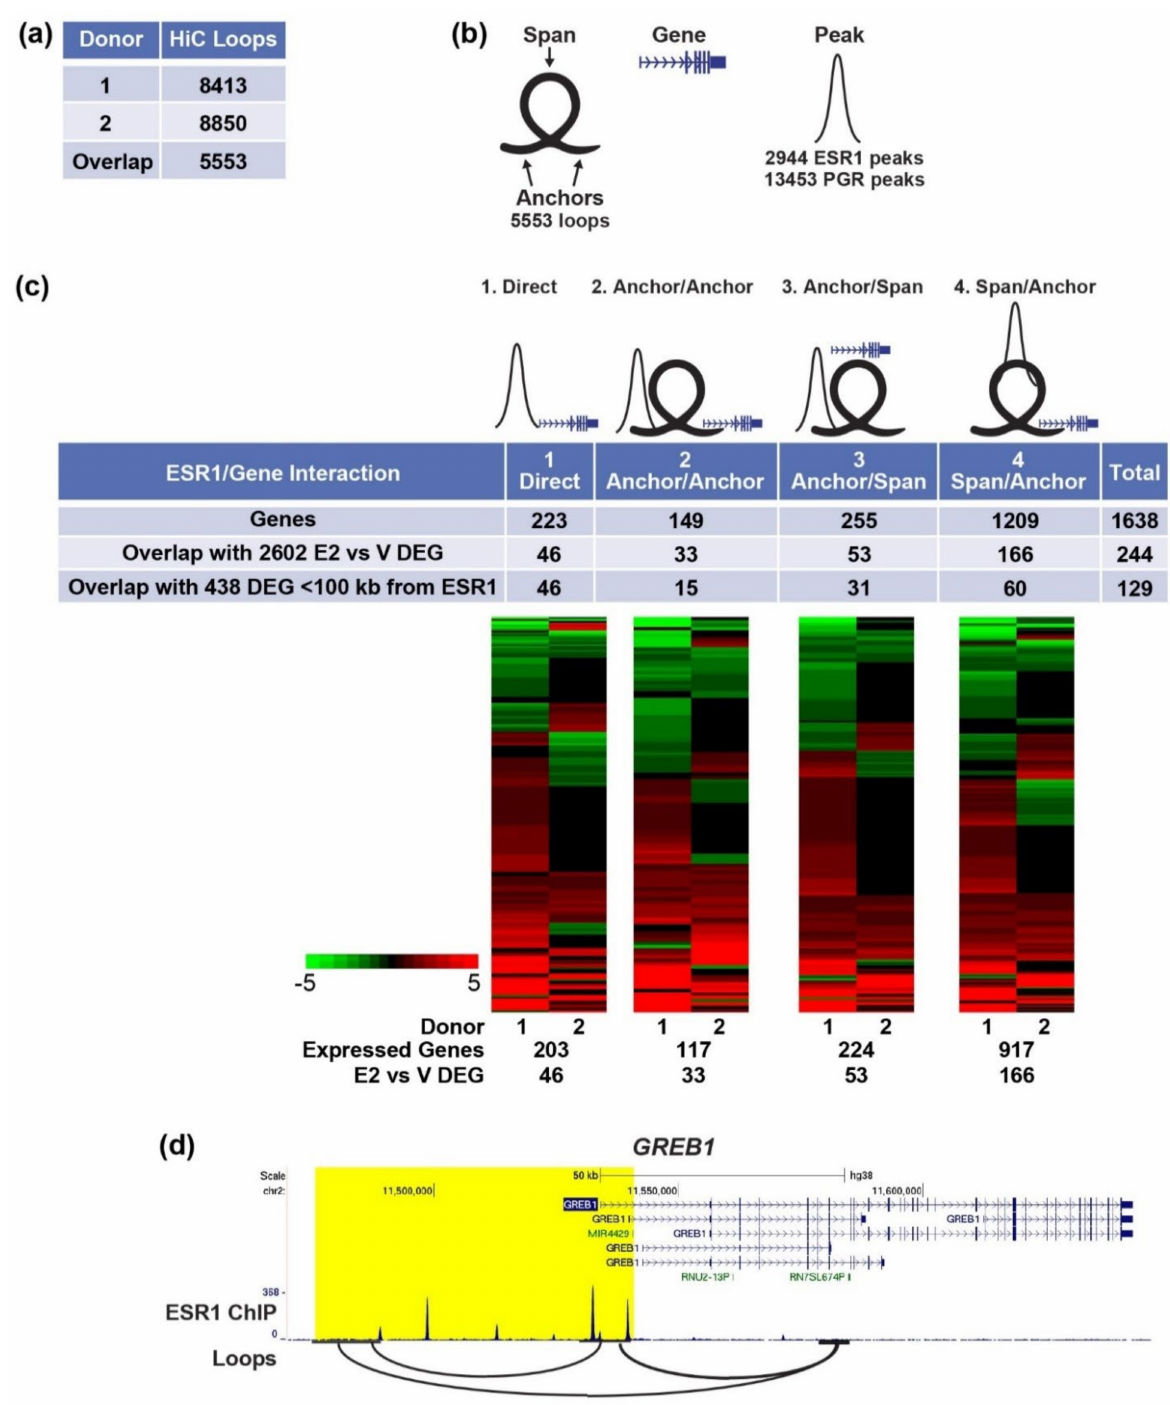
Figure 4. Analysis of ESR1-Gene Interactions Using HiC Loops. ( a ) HiC loops in each donor and overlapping loops; ( b ) Illustration of terms used in HiC ESR1/PGR ChIPseq and gene integration analysis to represent loops, with anchors with a connecting span, genes and ChIPseq peaks. ( c ) Genes in the four types of ESR1 peak-gene interactions described in the text. Heatmaps of fold E2 vs. V of all genes in each group expressed in either donor, with numbers of genes expressed and differentially expressed indicated below each. ( d ) In organoids, GREB1 is an example of direct, anchor/anchor and span/anchor ESR1-gene